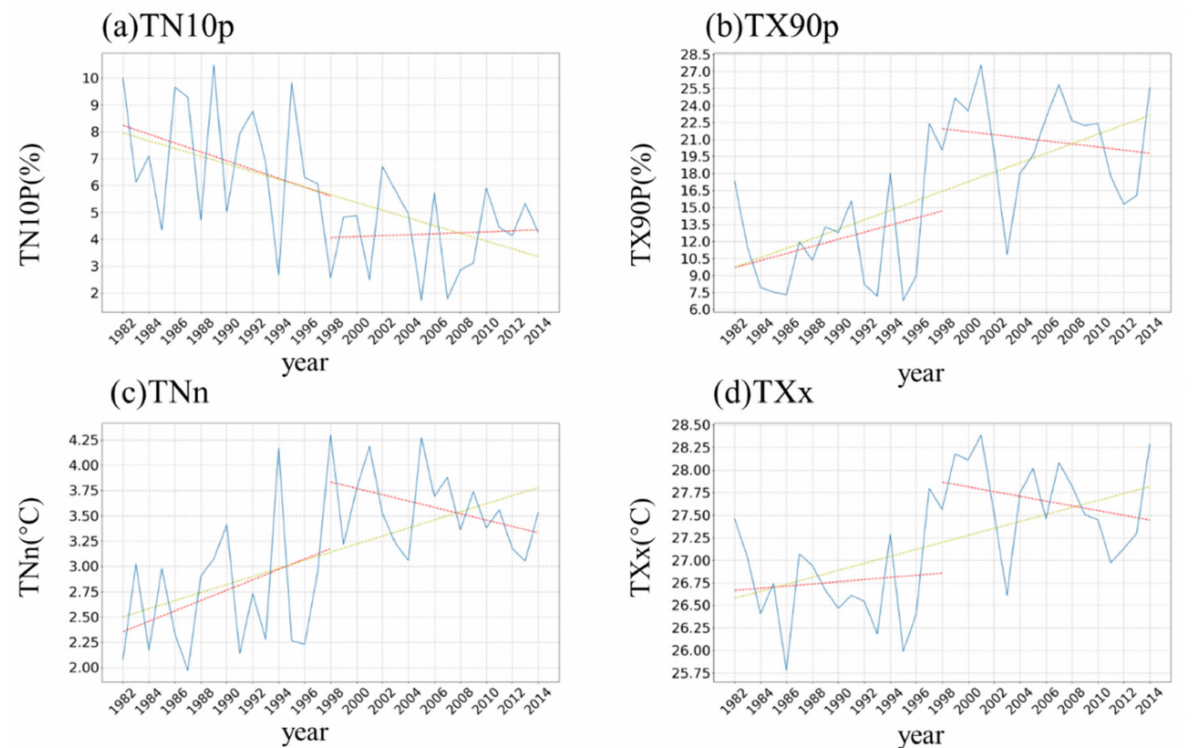
Figure 6. Time series of regional average extreme indexes which are related to temperature: ( a ) cold nights (TN10P) (days), ( b ) warm days (TXx90p) (days), ( c ) annual minima of daily minimum temper- ature (TNn) ( ◦ C), and ( d ) annual maxima of daily maximum temperature (TXx) ( ◦ C). The red line in the figure represents the trend from 1982–1998 and 1998–2014, the blue line represents the regional average of extreme indexes which are related to temperature from 1982–2014, and the yellow line represents the overall trend from